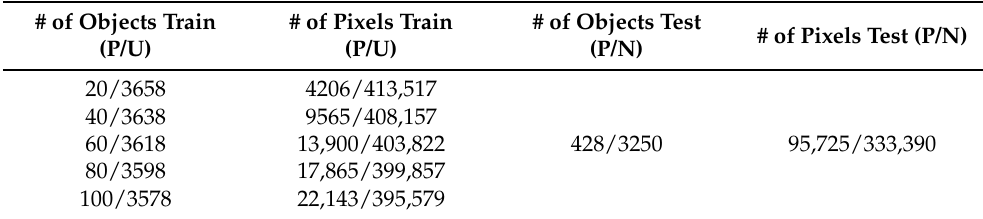
Table 3. Number of positive, unlabelled, and negative objects/pixels in the training and test set when the positive samples belong to the Forest land cover